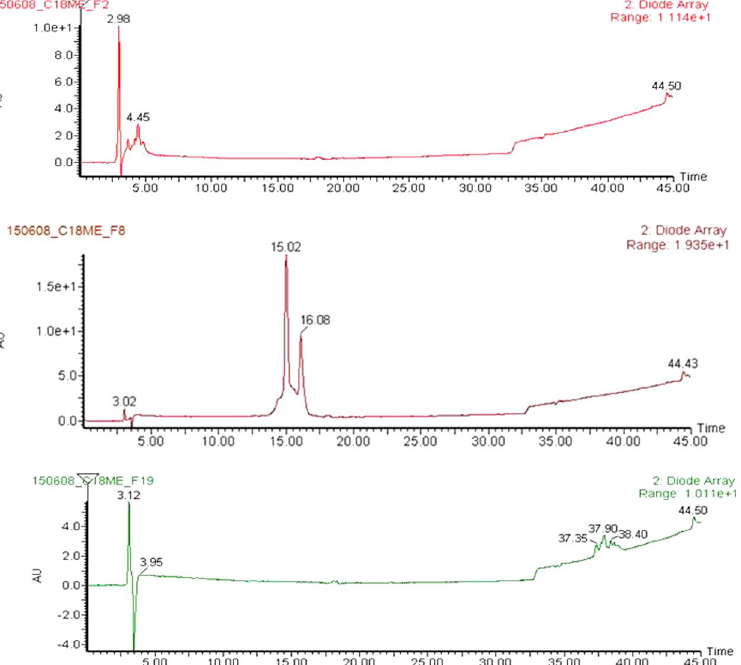
Figure 6. LC-MS analysis of fraction F2, F8, F19 (upper, middle and lower). Mobile phase A is 0.1% (v) TFA in water and B is 0.1% (v) FA in ACN. The gradient of separations was 0 min (5%, B) − 15 min (95%, B). The flow rate was 1 ml/min.